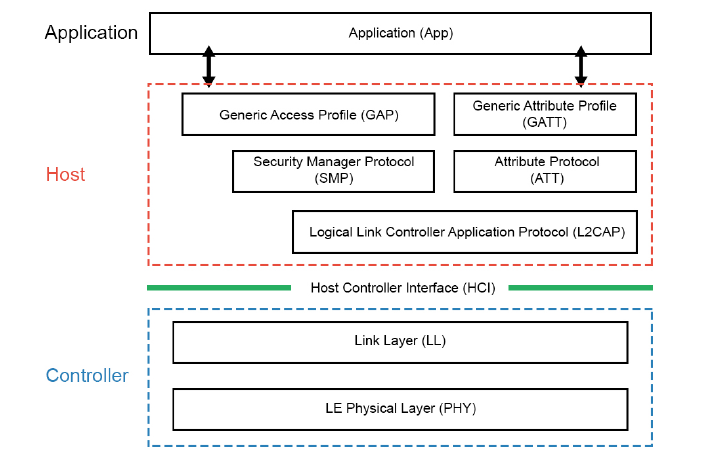
Figure 2. BLE protocol stack. The BLE stack consists of two parts: Host and Controller